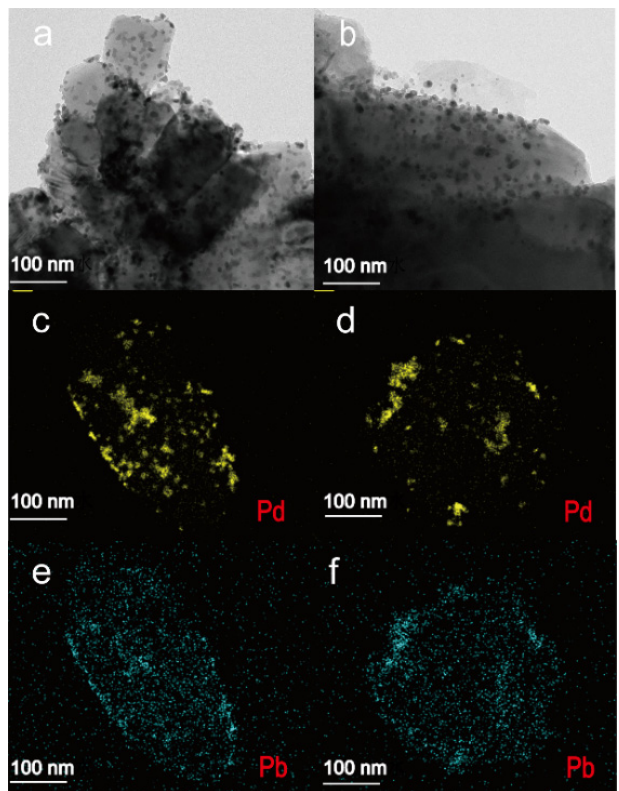
Figure 6. Transmission electron microscopic (TEM) images of post-reacted ( a ) Pd-Pb/PCC-04 and ( b ) commercial Pd-Pb/CaCO 3 catalytic material. ( c , d ) Pd and ( e , f ) Pb mapping on ( c , e ) Pd-Pb/PCC-04 and ( d , f ) commercial Pd-Pb Lindlar